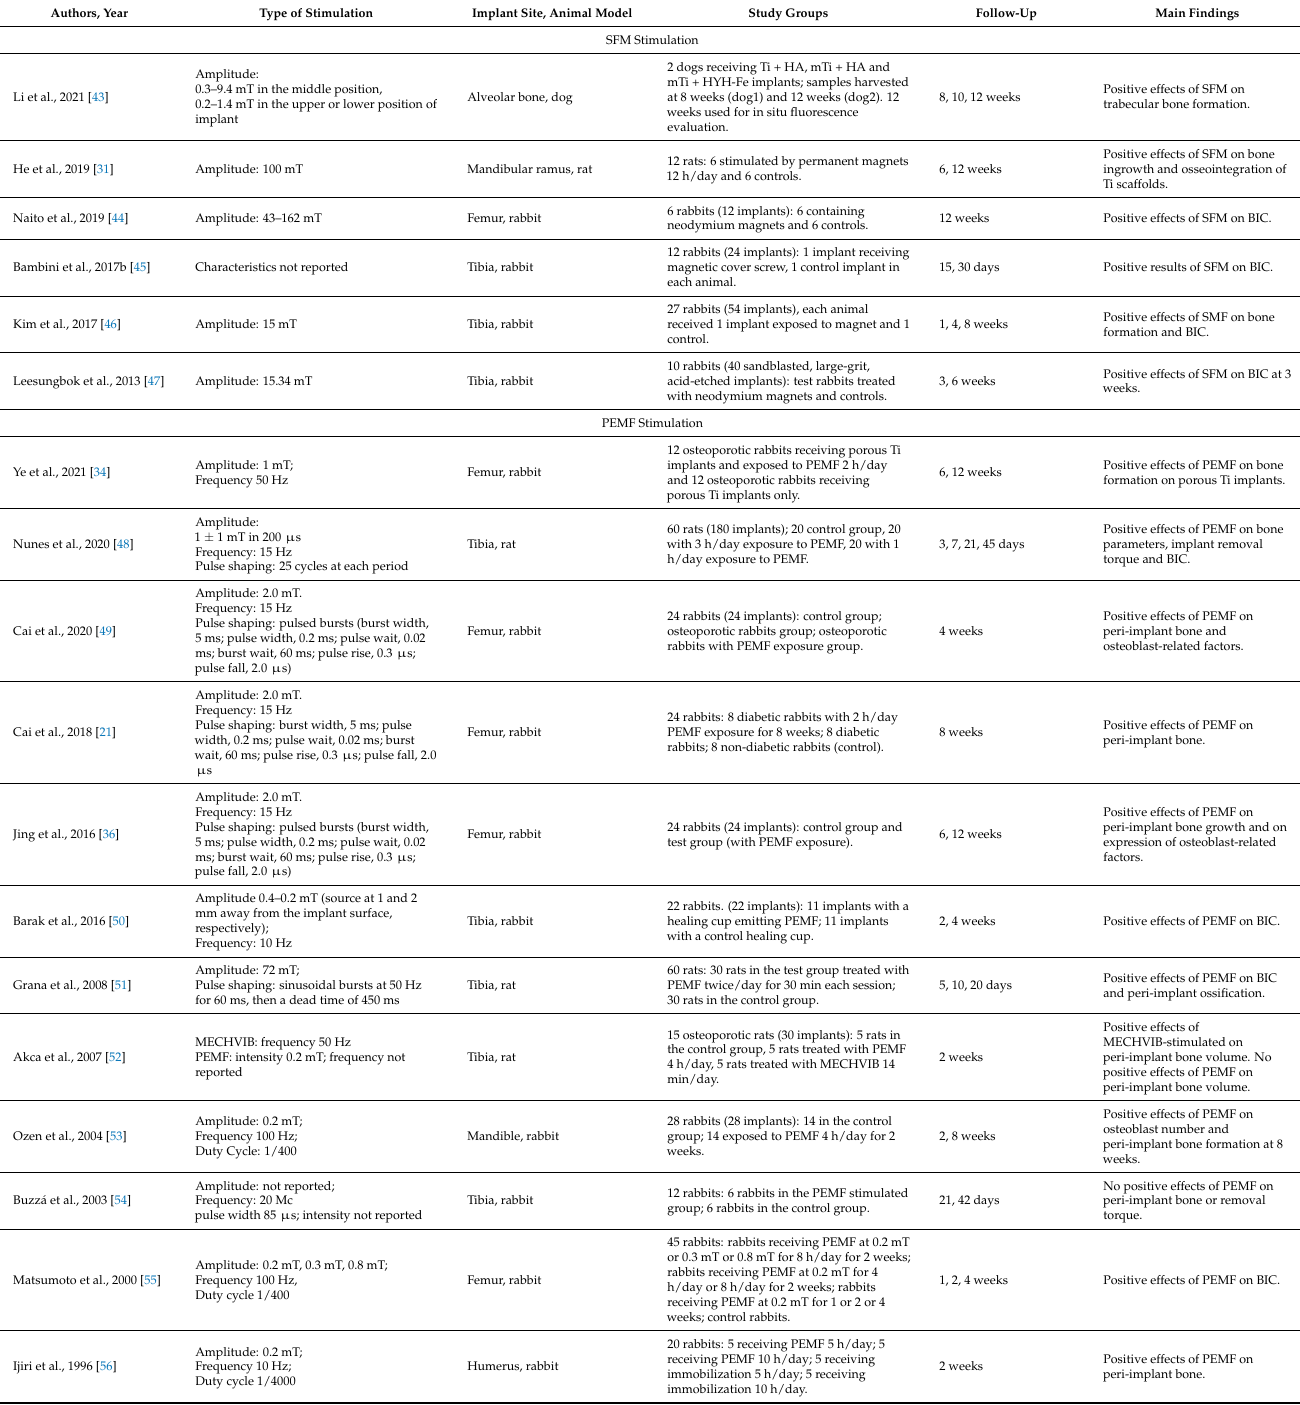
Table 3. Characteristics and main findings of the in vivo studies